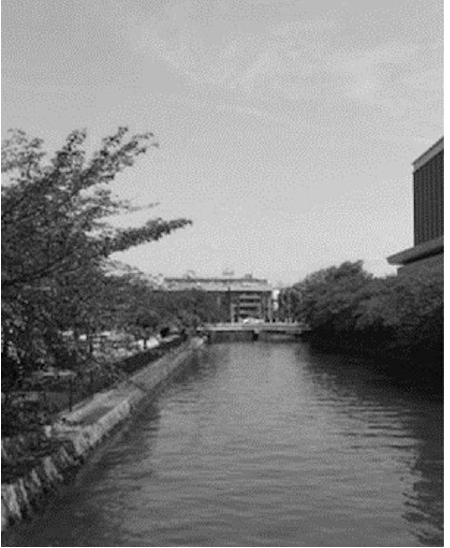
Figure 7. Lake Biwa Canal, Okazaki district Source: Taken bythe author, 2015